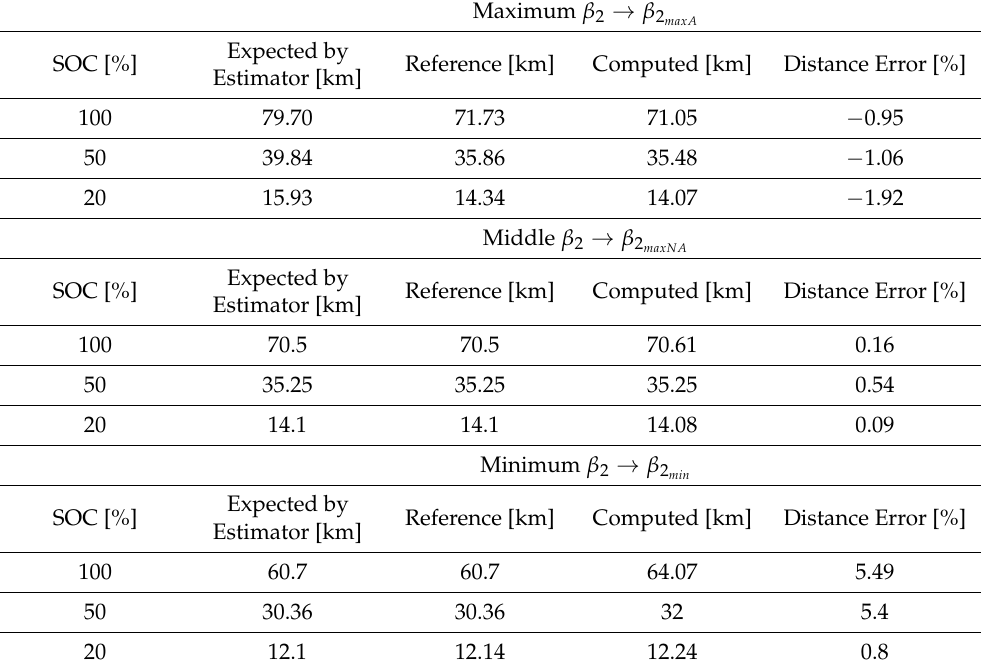
Table 3. Closed-Loop distance error